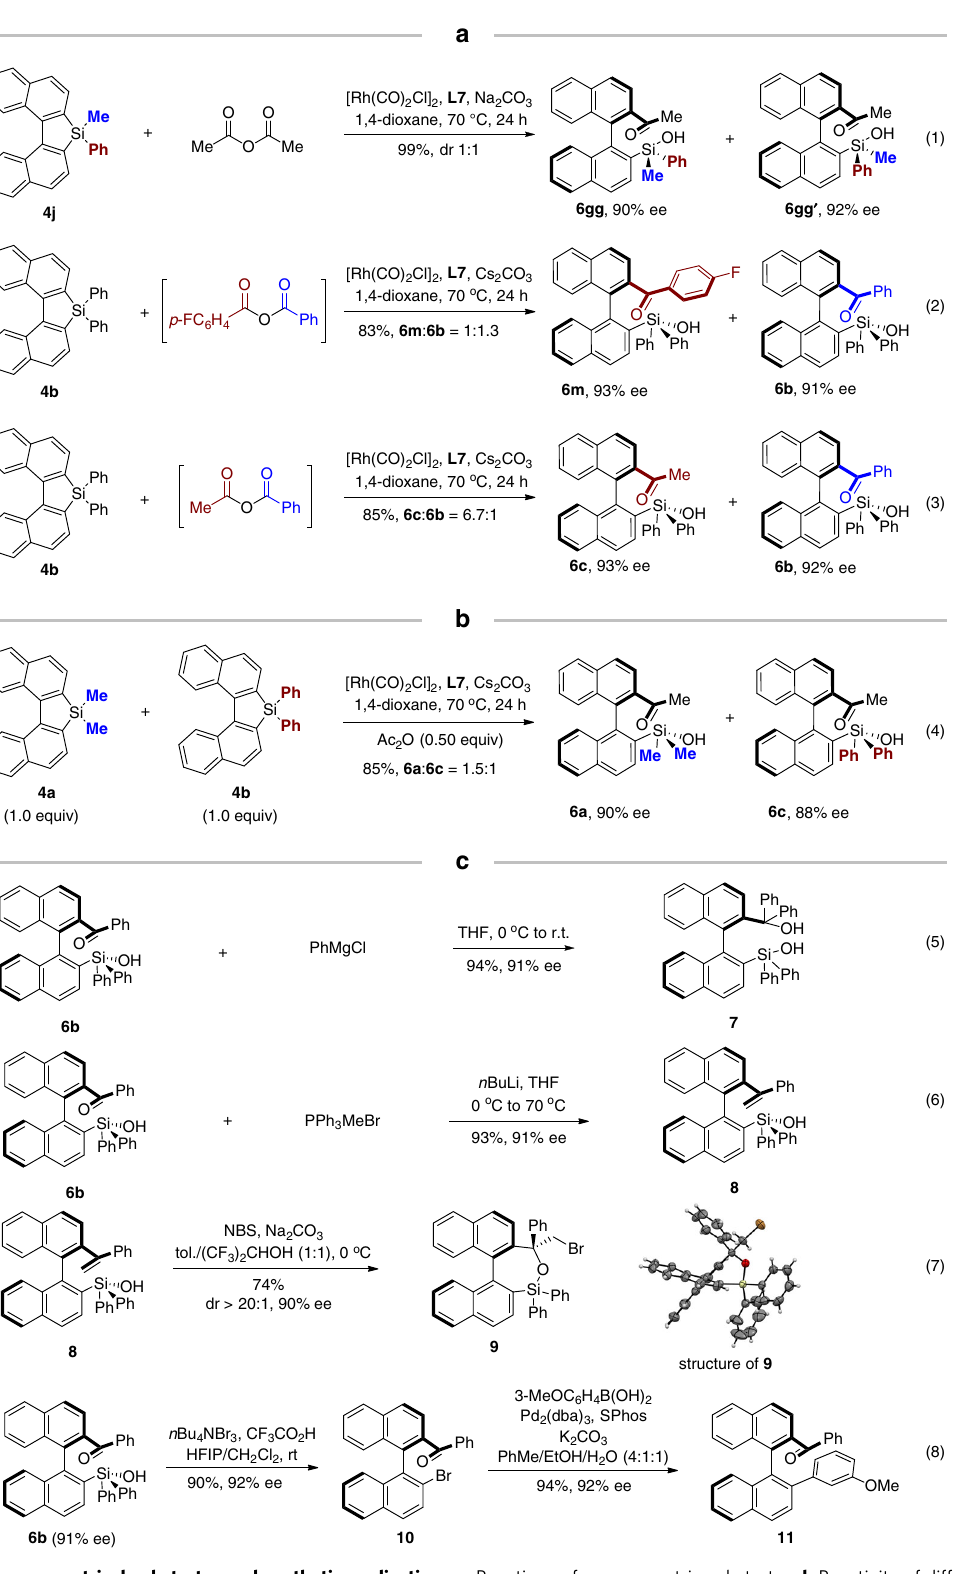
Fig. 5 Selectivity for unsymmetrical substrates and synthetic applications. a Reactions of nonsymmetric substrates. b Reactivity of different substituted substrates using acetic anhydride as limiting reagent. c Synthetic application of axially chiral